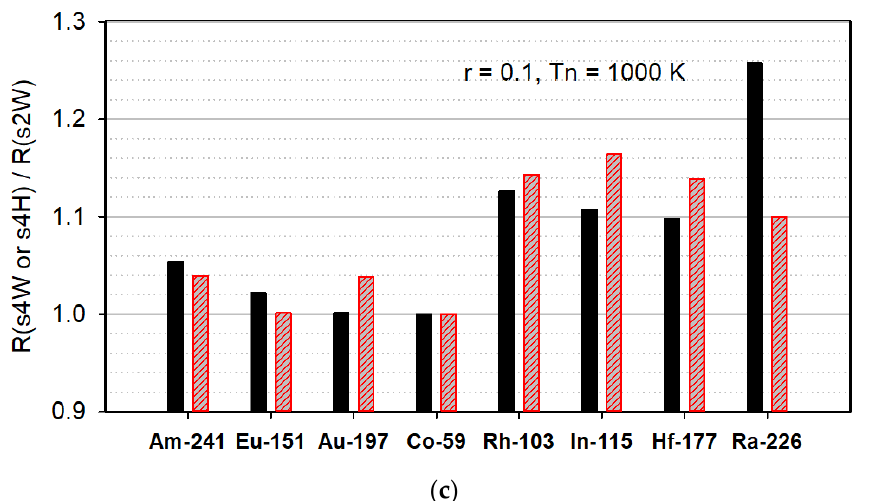
(cid:0) (cid:1) (cid:0) (cid:1) s W (black bar) and / R s W 2 4